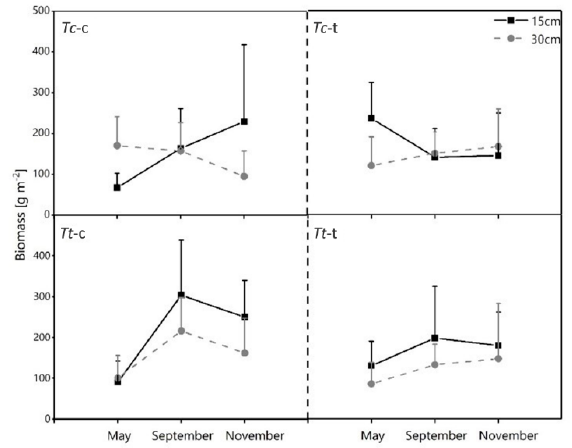
Figure 8. Horizontal development of fine root biomass (g m − 2 ) at a distance of 15 and 30 cm of the control and treatment groups of T. cordata and T. tomentosa during May, September, and November 2017. Values denote the average of all trees per cultivar and group ± the standard deviation.